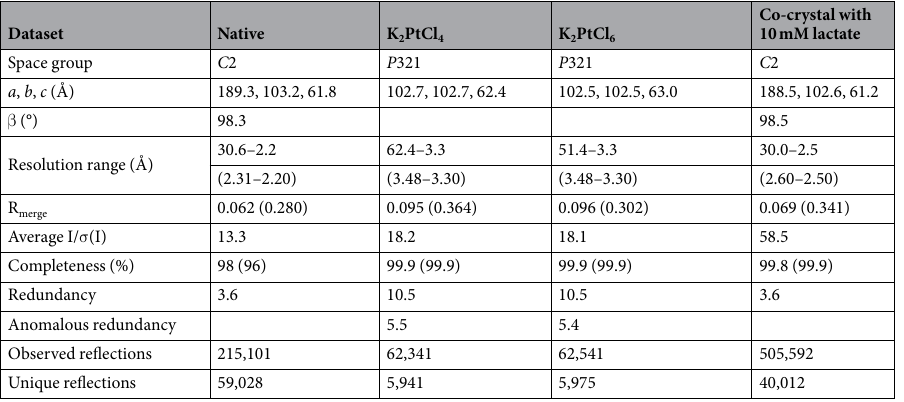
Table 2. X-ray Data collection and processing statistics. Values in parentheses are for the highest resolution